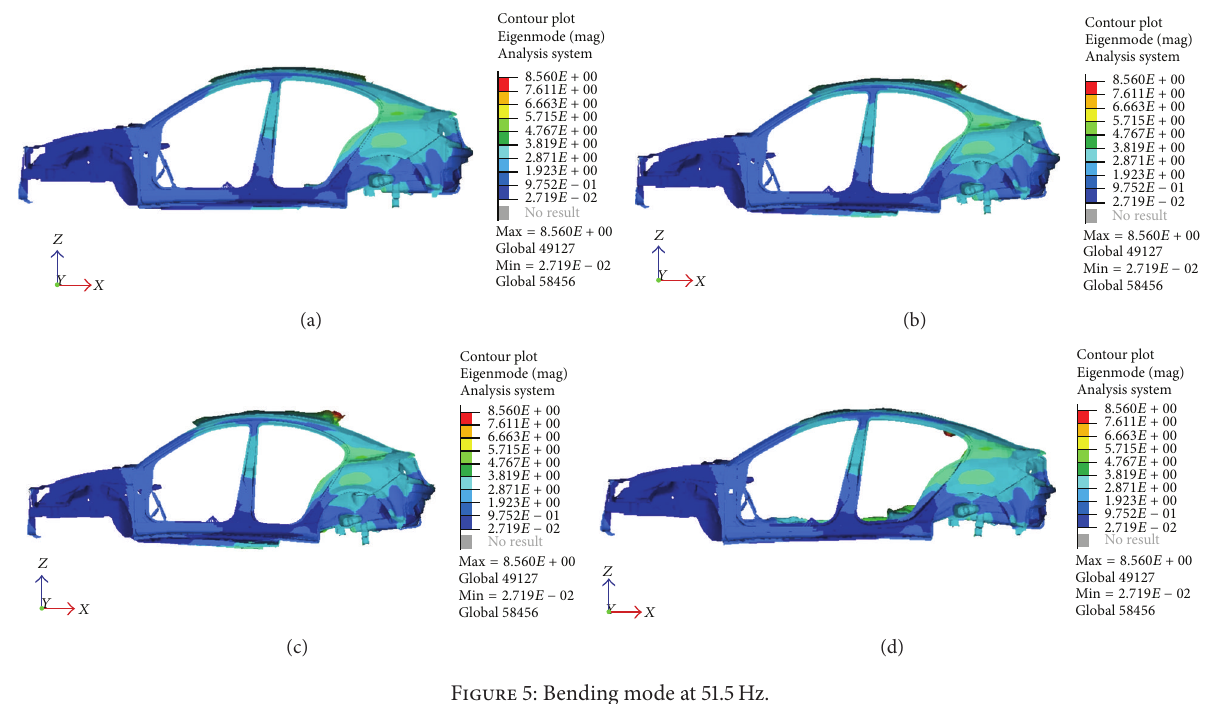
Figure 5: Bending mode at 51.5 Hz.